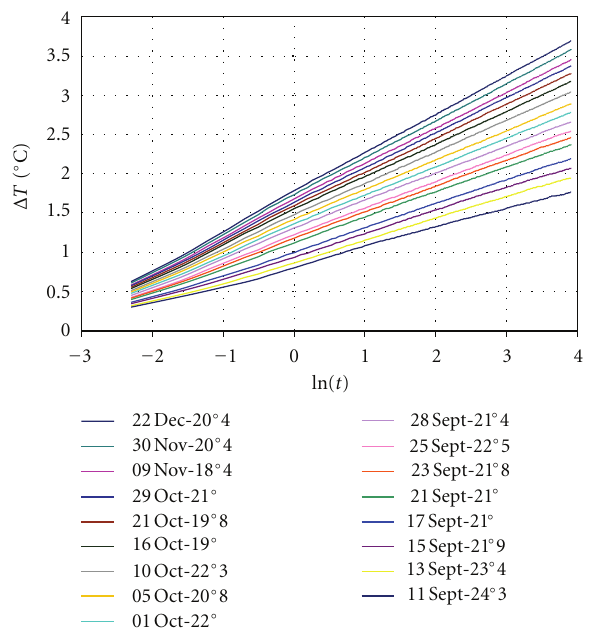
Figure 13: Evolutions of the Δ T/ ln( t ) curves with time and, consequently, with the lost of